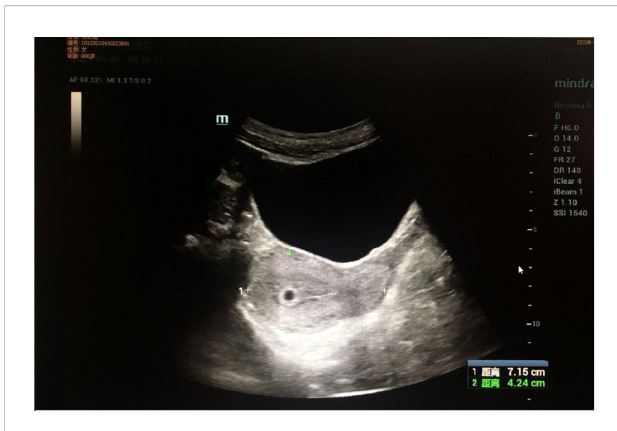
FIGURE 5 Ultrasound imaging: The gestational sac in the uterus was detected by ultrasound